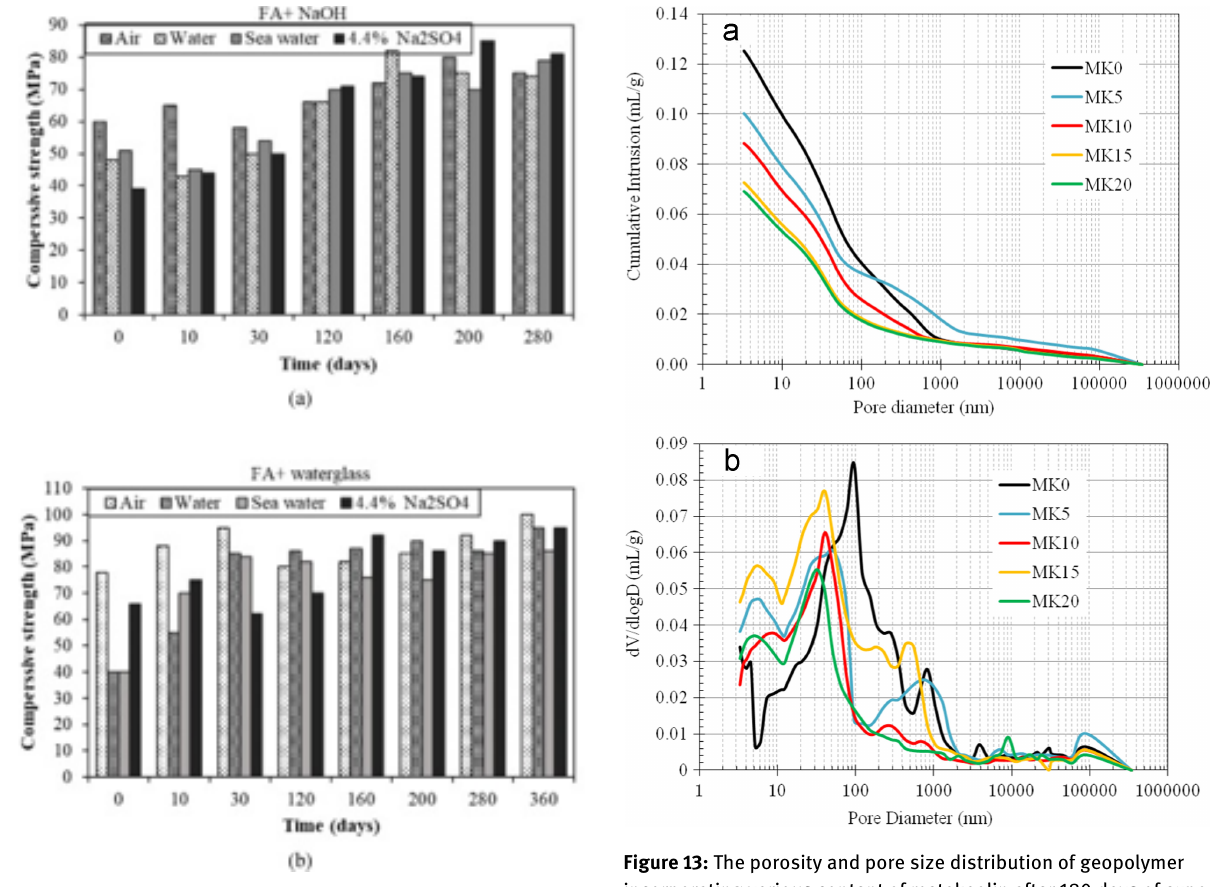
A decreased water permeability (2.46-4.67 × 10-11 m/s) for a GPC (activator-fly ash ratio of 0.30–0.40 cured at 60 ∘